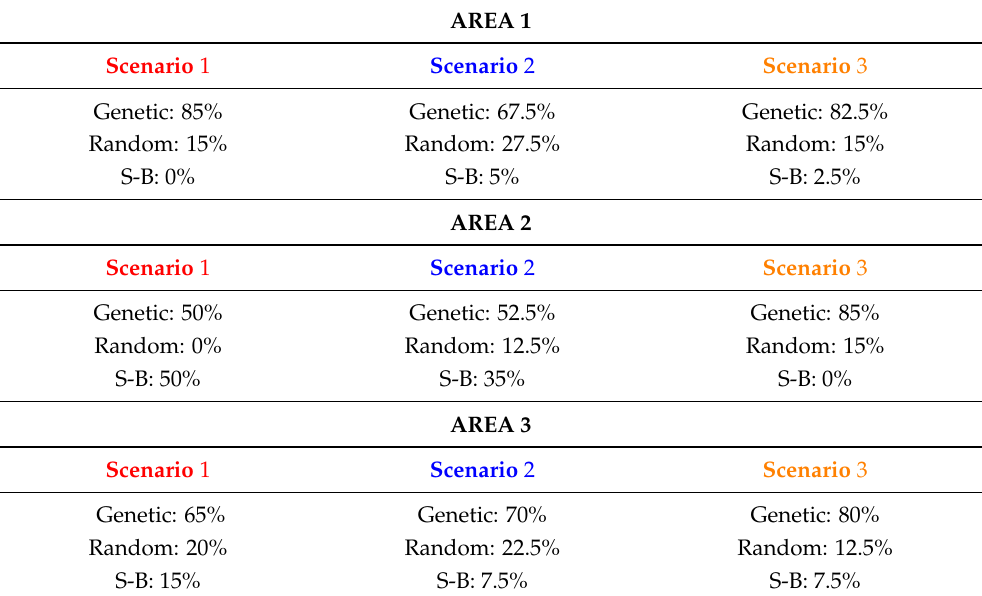
Table 5. Performance comparison of the ME metric of the 3 path planners over the 3 areas of interest with different starting